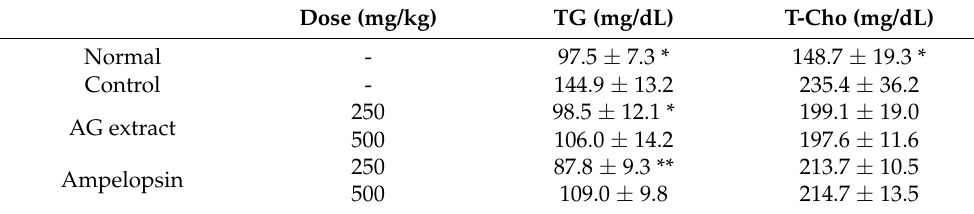
Table 2. Effects of AG extract and ampelopsin on serum TG and T-Cho levels in HFD-fed mice.